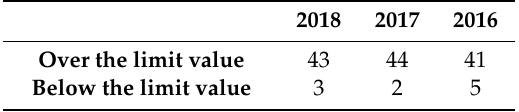
Table 5. Discretionary accruals for selected agricultural